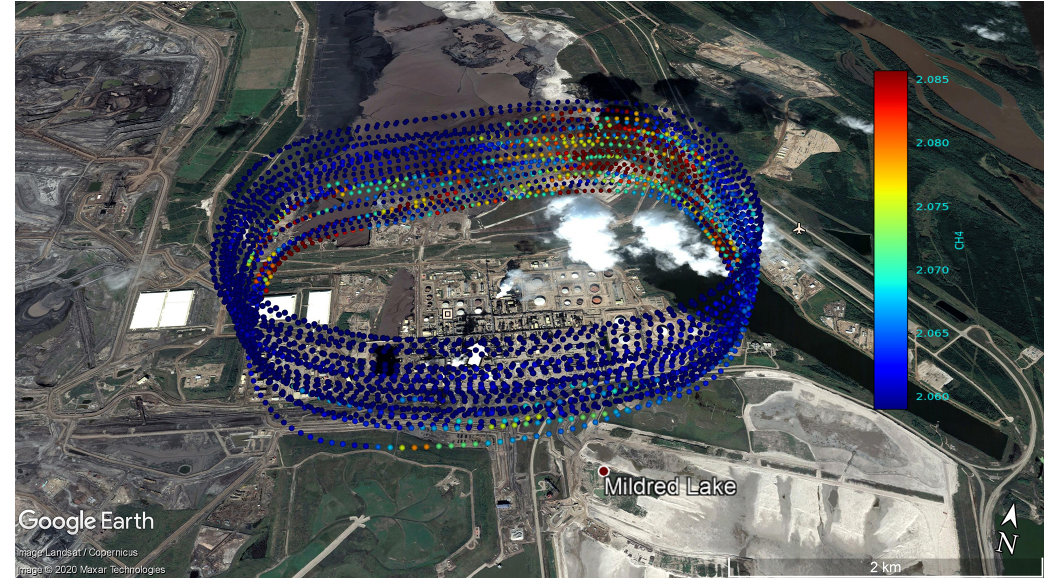
Figure 2. The flight path for F04 depicts the mixing ratio of CH 4 (ppm) measured at 1Hz intervals for each of the 25 laps around the Syncrude plant. A Google Earth historical image from September 2016 was used, as it shows an emission plume with wind conditions similar to the 2017 F04 flight. A KML file containing mixing ratios provided by Scientific Aviation was overlaid on the image. Each measurement of a mixing ratio is depicted as a dot, and the layout traces the 25-lap flight path for sampling during F04. Satellite imagery ©2020 Maxar Technologies, Google Earth.